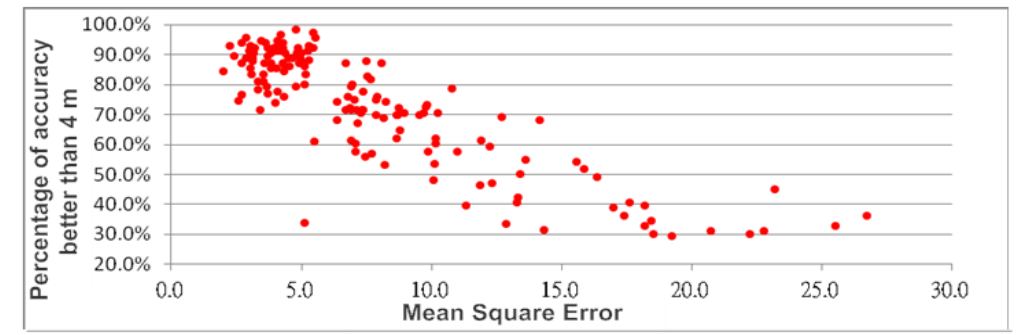
Figure 6. Relationship between mean square error and accuracy.